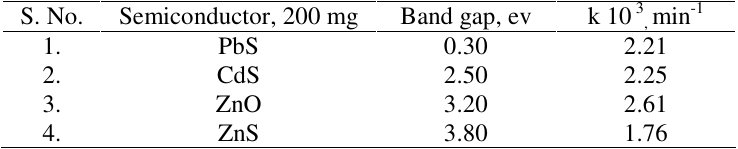
Table 6. Effect of band gap of